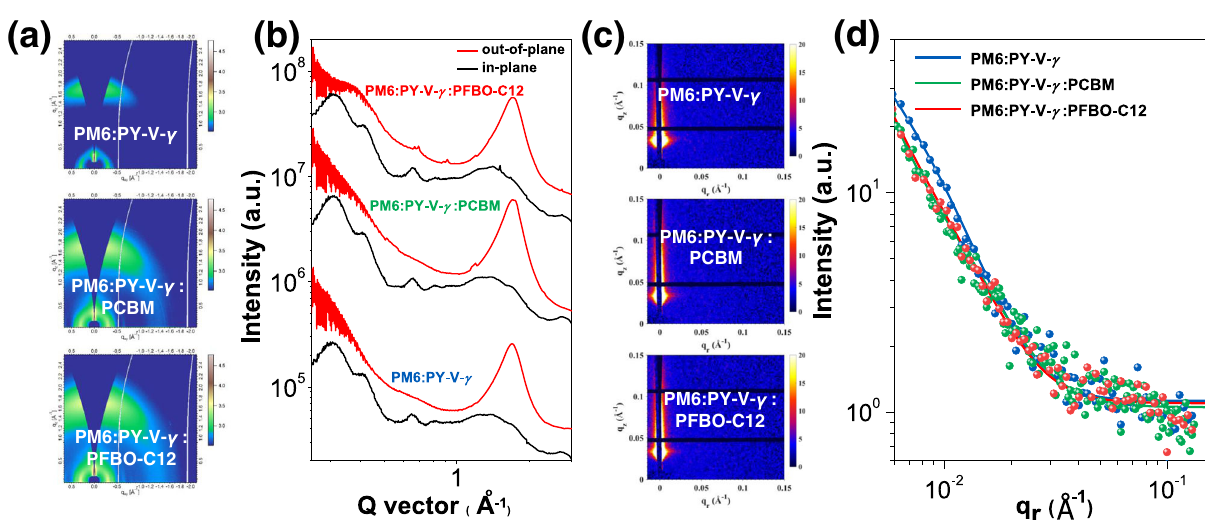
Fig. 3 | Morphology characterization. a 2D GIWAXS patterns of the blend fi lms and b the corresponding 1D GIWAXS line-cuts of the in-plane (black line) and out- of-plane (red line) directions. c 2D GISAXS patterns of the blend fi lms and d the